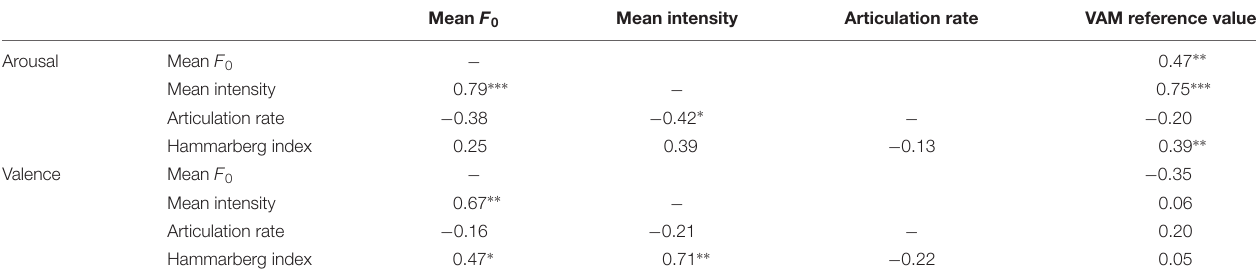
TABLE 1 | Correlation coefficients per emotion dimension.